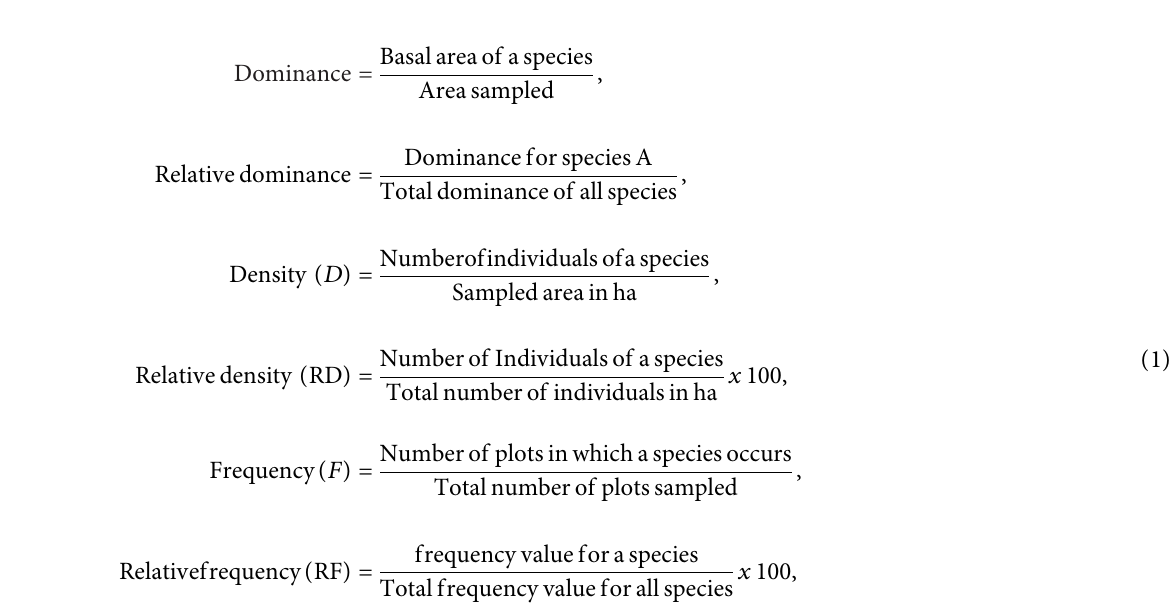
Figure 1: Te study area